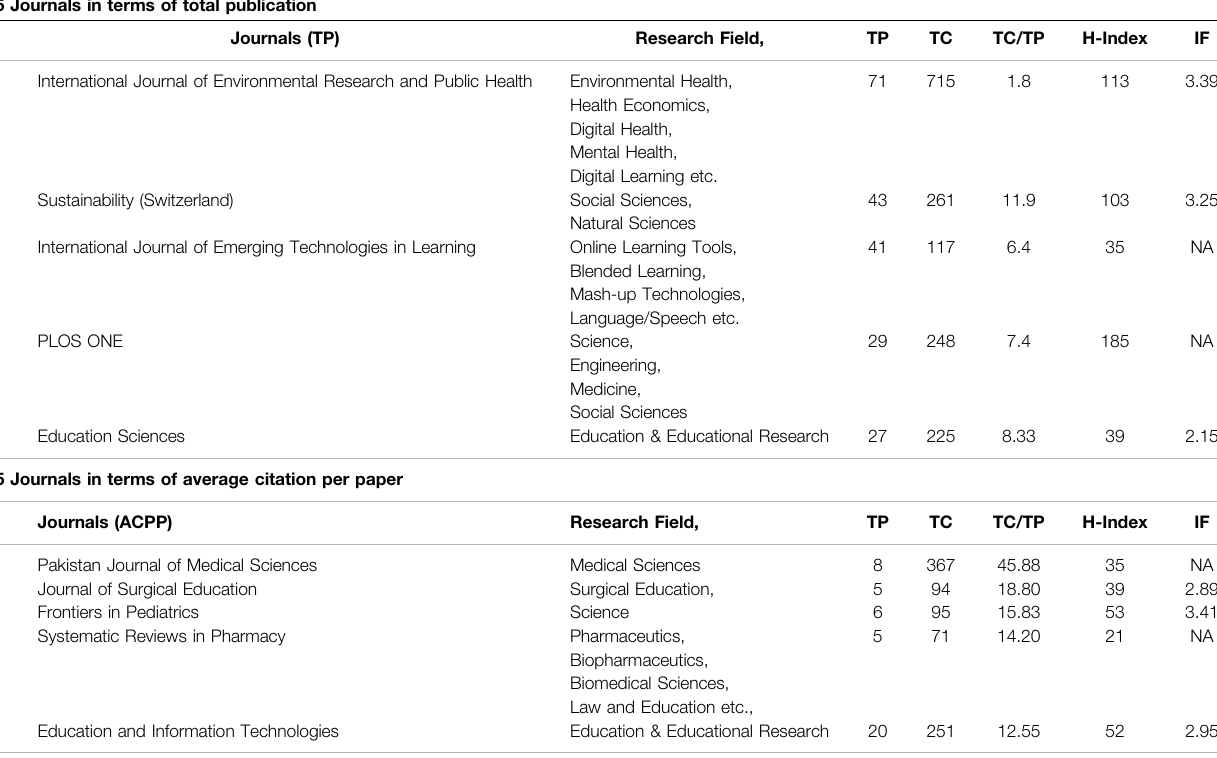
TABLE 4 | Top 5 productive journals (total publication and average citation per